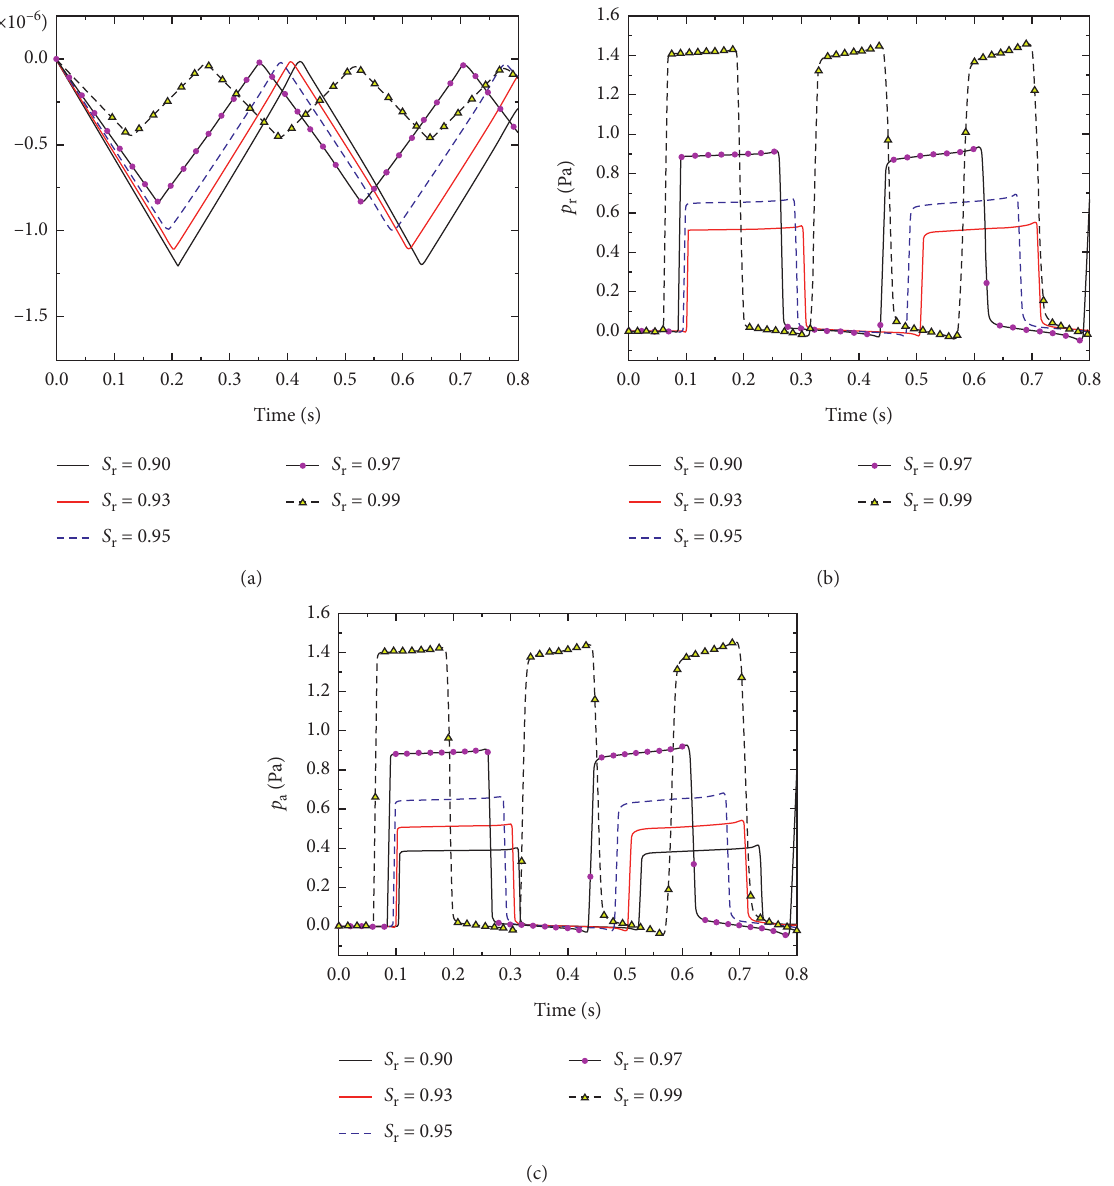
Figure 5: Distributions of the vertical displacement of solid particles u time using different fluid saturation values ( S r � 0.9 to 0.99). (a) u z . (b) p f . (c) p a